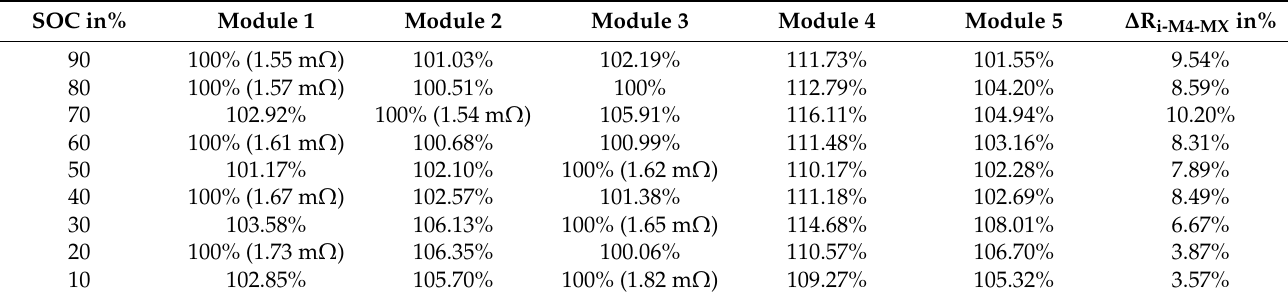
Table 4. Comparison of different SOC working points at 0.5 s in the relaxation phase, internal resistances are normalized to the best module.